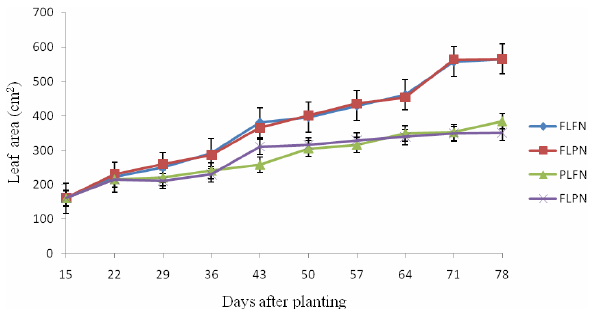
Fig. 3. Effect of light and nutrient stress on the leaf